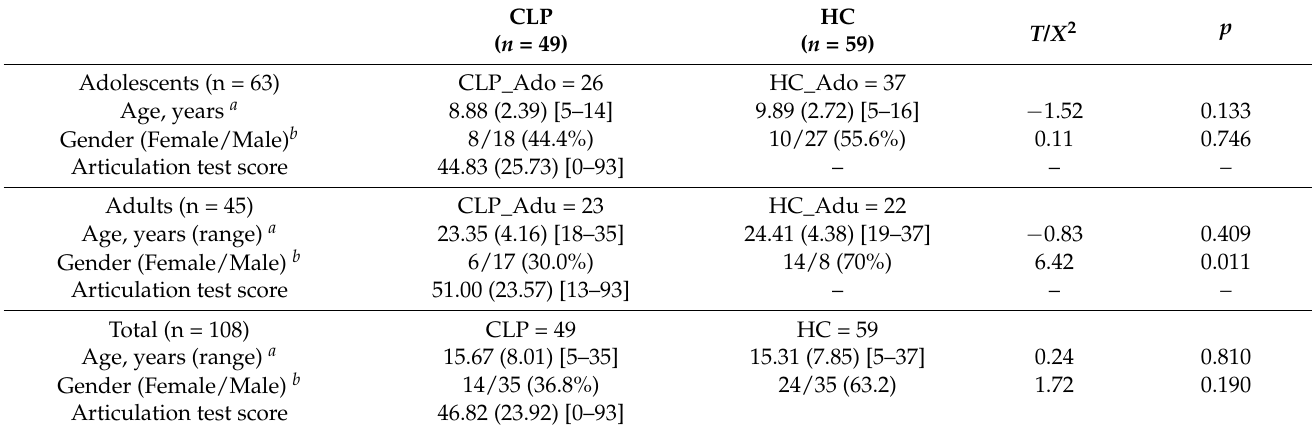
Table 1. Demographic and clinical characteristics of participants enrolled in this